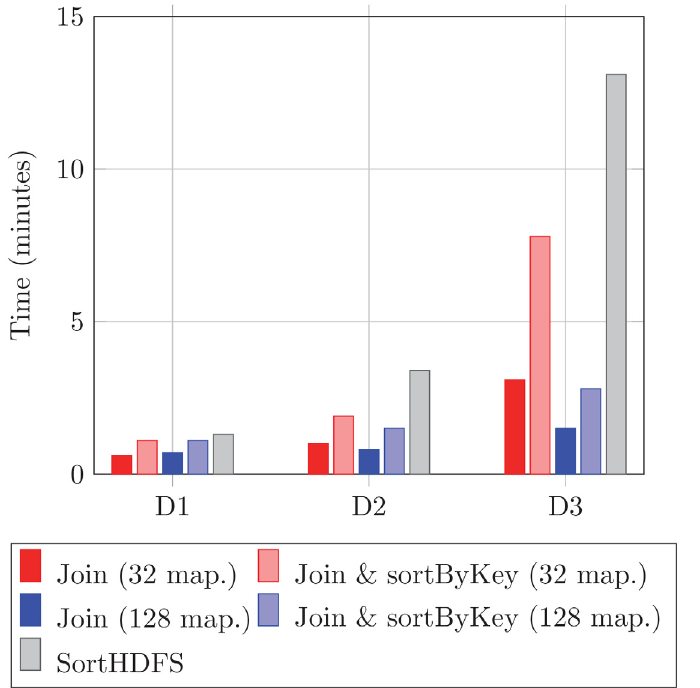
Fig 5. Overhead of the RDDs sorting operation considering different